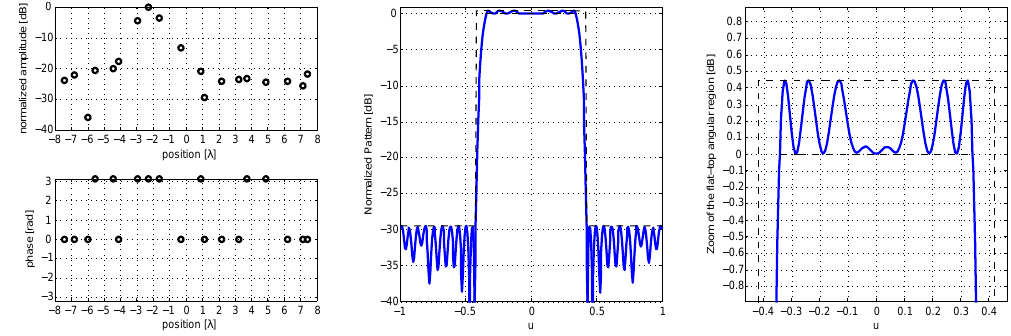
Figure 7. The second flat-top pattern achieved by means of SFGAP; from left to right : amplitude and phase of the excitations, power pattern of the array with its mask, highlight of the flat-top part of the pattern.